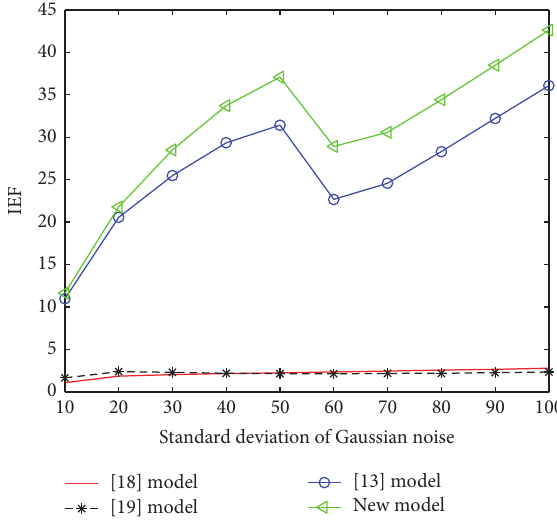
Figure 10: PSNR (dB) graph of [13, 18, 19] and new algorithms for various Gaussian noise for Bus video sequence.